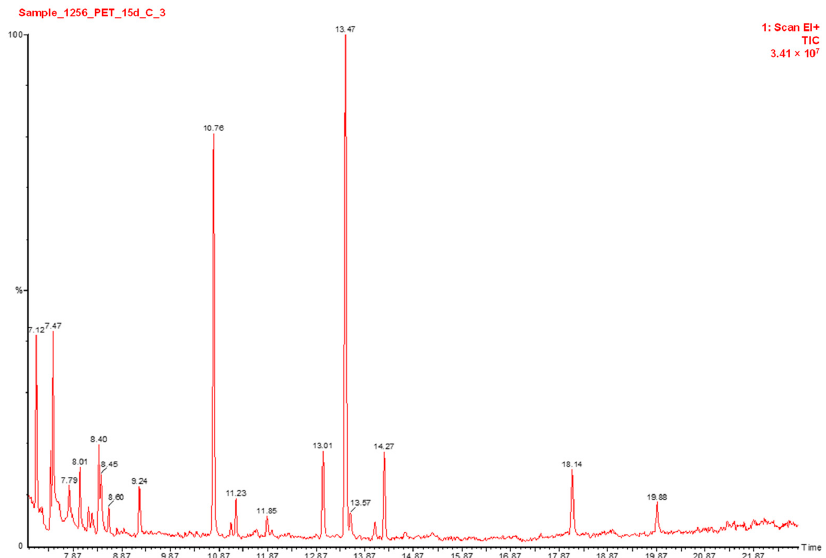
Figure 3. Chromatographic separation of major FAs recovered from the lipids of liquid whole egg product kept for 15 days in PET packaging: 10.76 min (C16:0—hexadecanoic